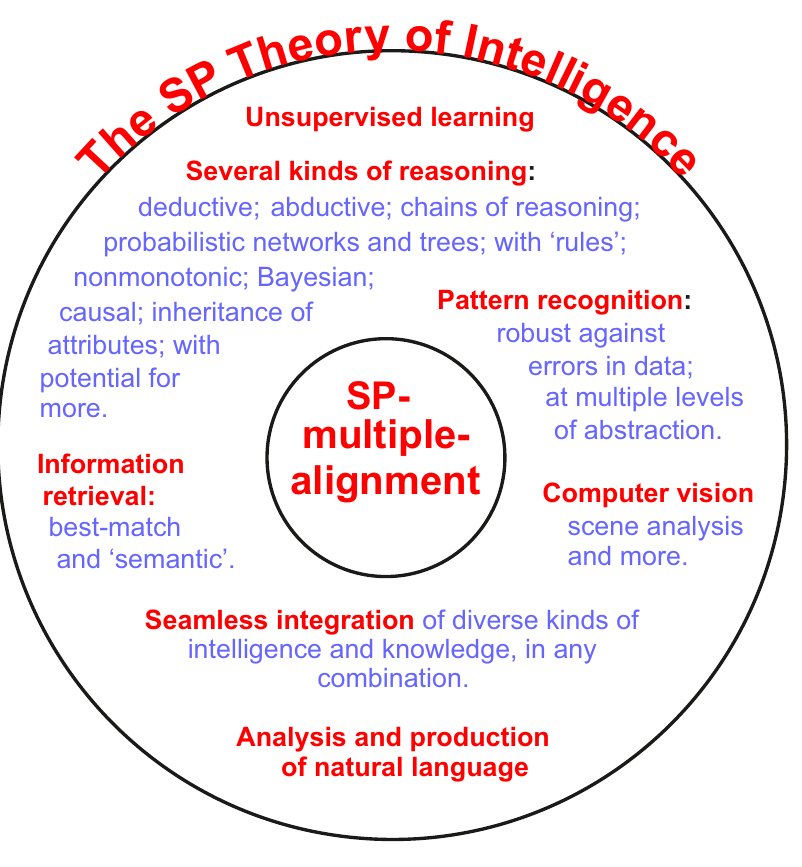
Figure A5. A schematic representation of versatility and seamless integration in the SPTI, with the SPMA concept centre